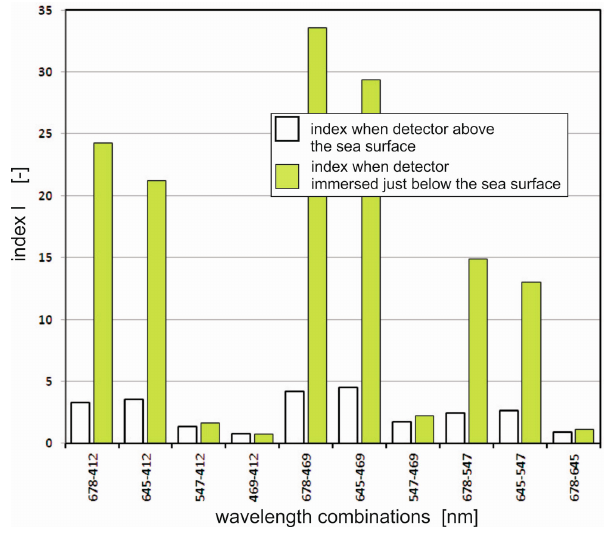
Figure 10. Index I for combinations of each studied wavelength.